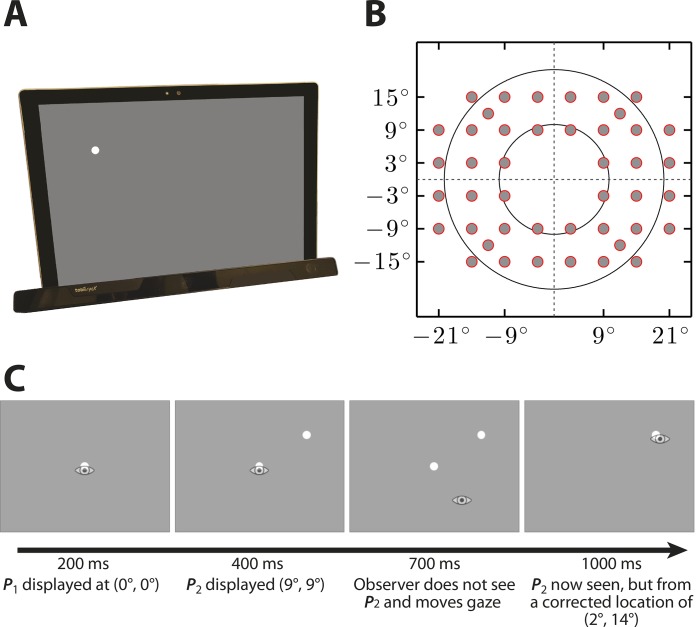
Eyecatcher Methods. (A) The key test equipment, comprised of a Microsoft Surface Pro 3 tablet (viewing at 50 cm), and a Tobii EyeX eye-tracker, which was attached to the bottom of the screen by magnets. (B) The underlying test grid, in retinal coordinates (though note that actual locations could deviate from the underlying grid, as shown in Fig. 2). (C) An example trial sequence, in which a stimuli are presented relative to the current point of fixation, and the eye-tracker determines whether the participant moved their eyes toward the target. See body text for details.